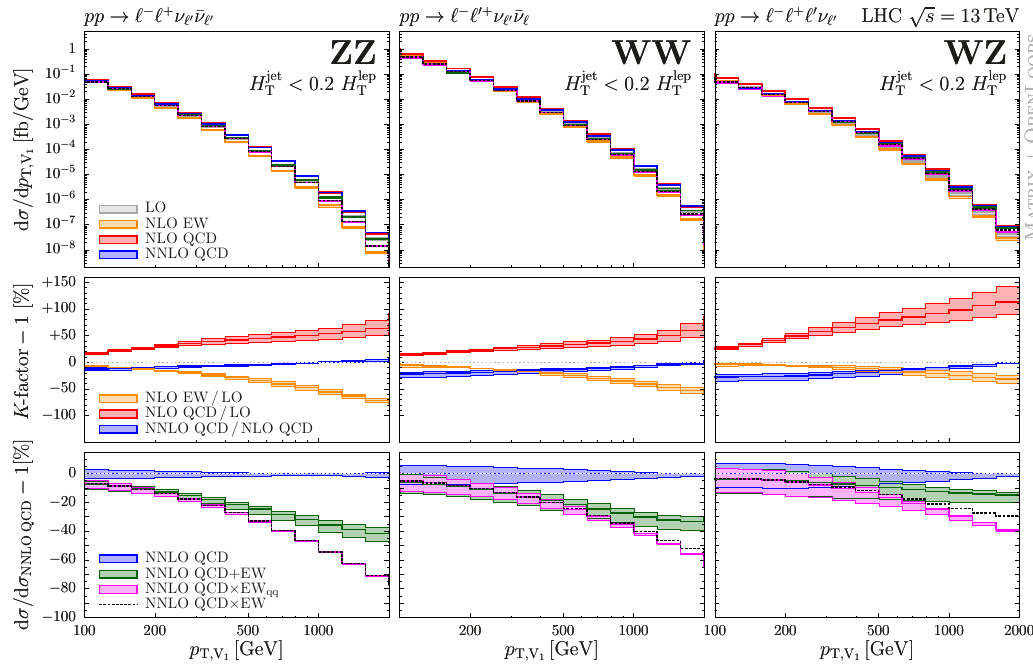
Figure 13 . Distribution in the transverse momentum of the harder reconstructed vector boson for the processes (3.1){(3.3) at 13 TeV. Same plots as in (cid:12)gure 8, but in addition to the baseline cuts also the jet veto (3.16) is applied. Note that here and in the following (cid:12)gures the corrections are given in